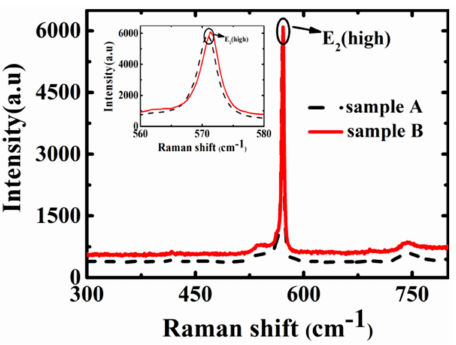
Figure 3. Raman spectra of both samples (the inset is a partially enlarged view of the spectra).